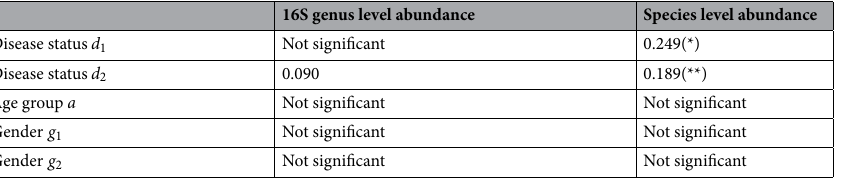
Table 2. Coefficients of variables for multiple regression on matrices. The coefficient for disease status d 1 indicates the difference of beta diversity between (D, H) samples versus (H, H) samples and the coefficient for disease status d 2 indicates the beta diversity difference between (D, D) samples and (H, H) samples, where D and H represent UC and healthy individuals, respectively. The coefficient for age a measures the contribution of age to beta diversity. The coefficient for gender g 1 measures the beta diversity difference between (M, F) individuals versus (M, M) individuals. Similarly, the coefficient for gender g 2 measures the beta diversity difference between (F, F) individuals versus (M, M) individuals, where M and F represent male and female, respectively. If a partial regression coefficient is reported, its significance level is < 0.05. *P ≤ 0.01 and **P ≤